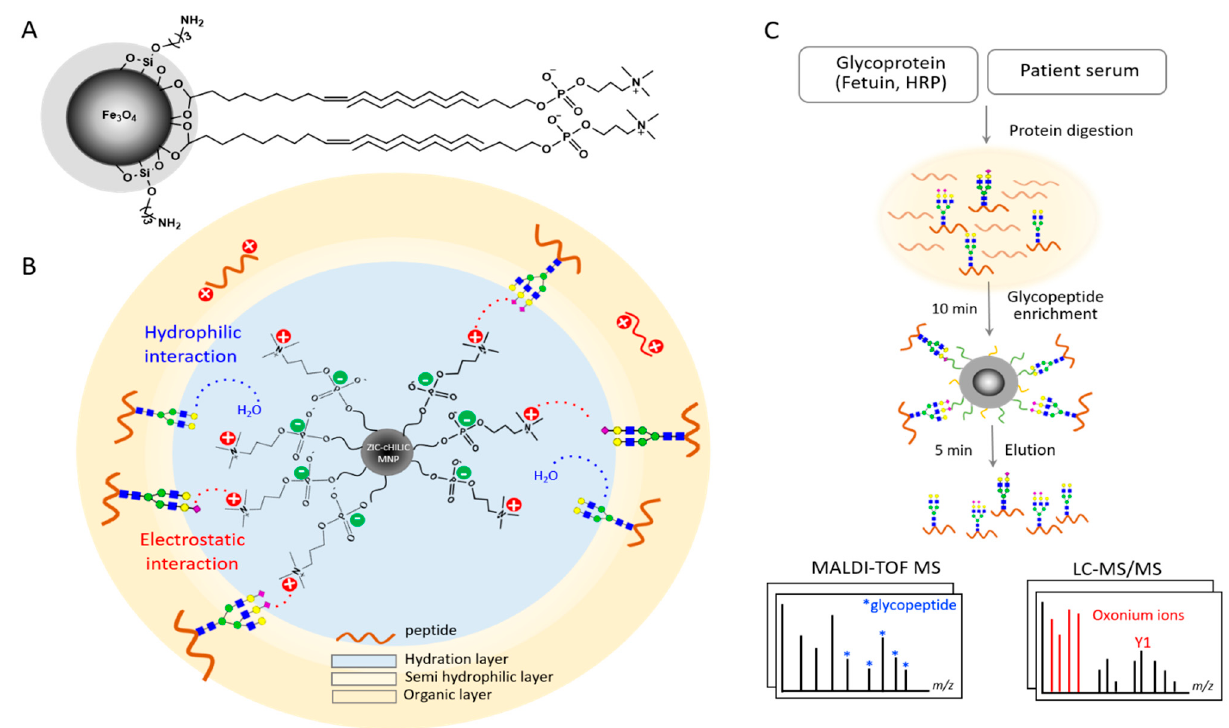
Figure 1. Proposed mechanism and workflow of glycopeptide enrichment using ZIC-cHILIC@MNPs. ( A ) Structure of ZIC-cHILIC@MNPs. ( B ) Proposed mechanism and ( C ) workflow of glycopeptide enrichment by using ZIC-cHILIC@MNPs.